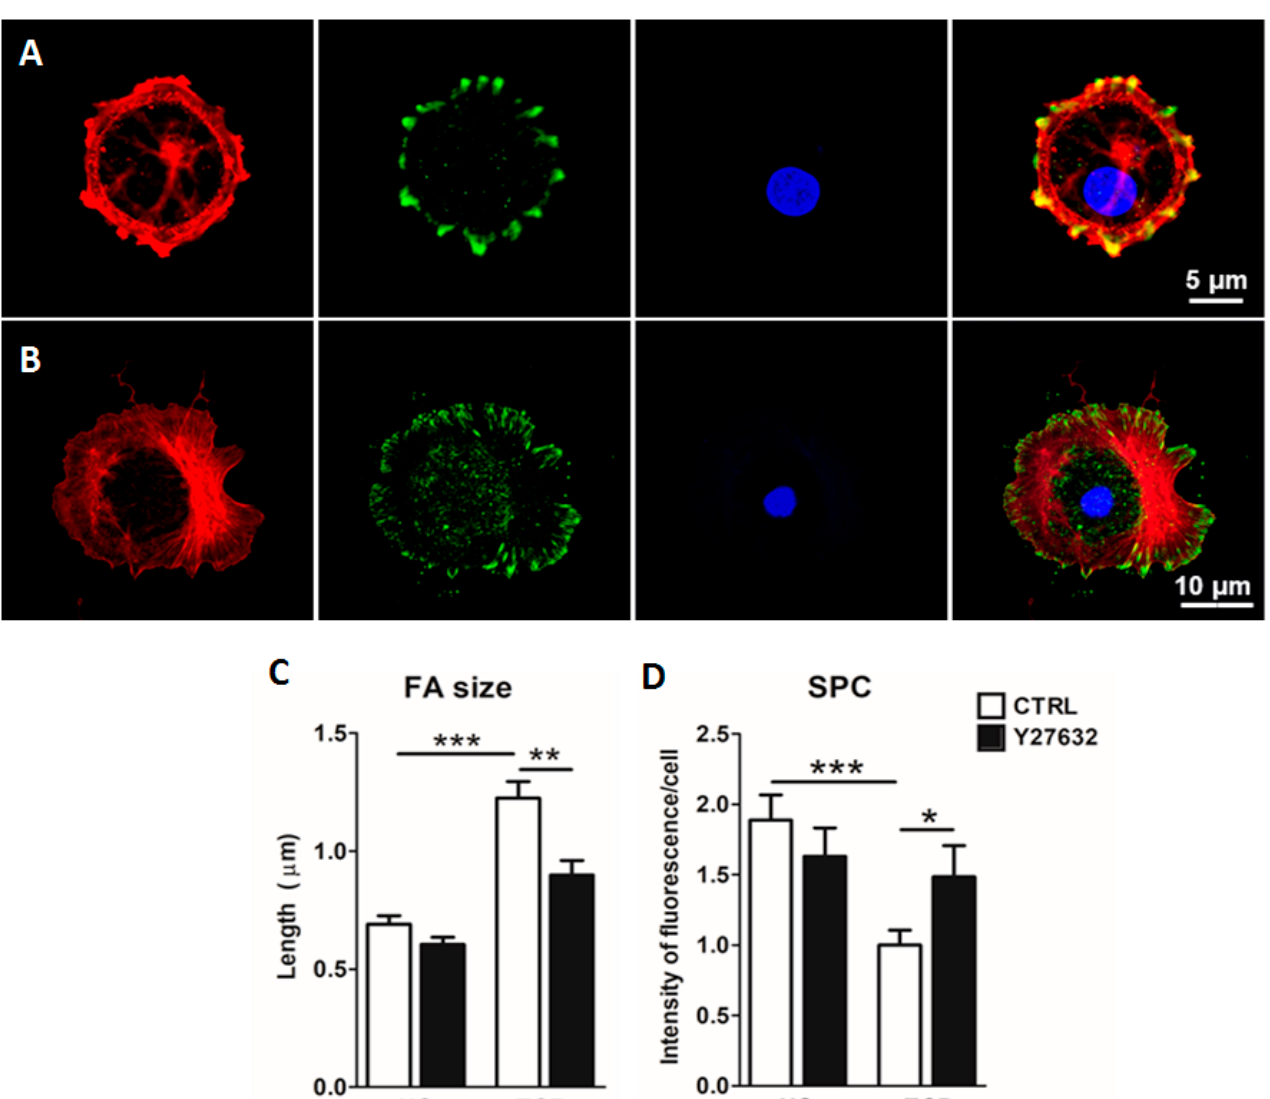
Figure 5. Representative images of focal adhesions (FAs) in cells cultured on hydrogels ( A ) and plate ( B ). Red: phalloidin, green: paxillin, blue: nuclei. Quantification of the FA length ( C ) and the intensity of surfactant protein C (SPC) of alveolar type II cultured on hydrogels for 3 days with (Y27632) and without (CTRL) the addition of the ROCK inhibitor ( D ), * p < 0.05, ** p < 0.01, *** p < 0.001. 2.4. Primary Alveolar Epithelial Cells Cultured on Lung-Derived Hydrogels Can Be Subcultured The potential ability to subculture primary ATII cells was studied. Cells were cultured for 3 days on lung hydrogels and, after that time, lung-derived hydrogels were digested with collagenase, and cells were seeded again on plates. Sixteen hours later, they were immunostained for typical epithelial (EpCAM) and ATII (SFTPC) markers (Figure 6). Subcultured cells were positive for both, EpCAM and SFTPC markers. These results indicate that lung-derived hydrogels allow for primary AECs